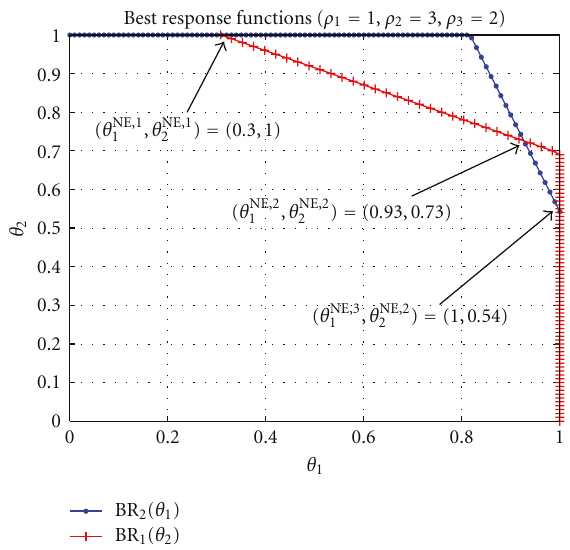
Figure 4: Best replies for a system composed of an IC in band (1) and IRC in band (2) when the ZDSAF protocol is assumed (fixed amplification factor). The number of equilibria is generally three as indicated the